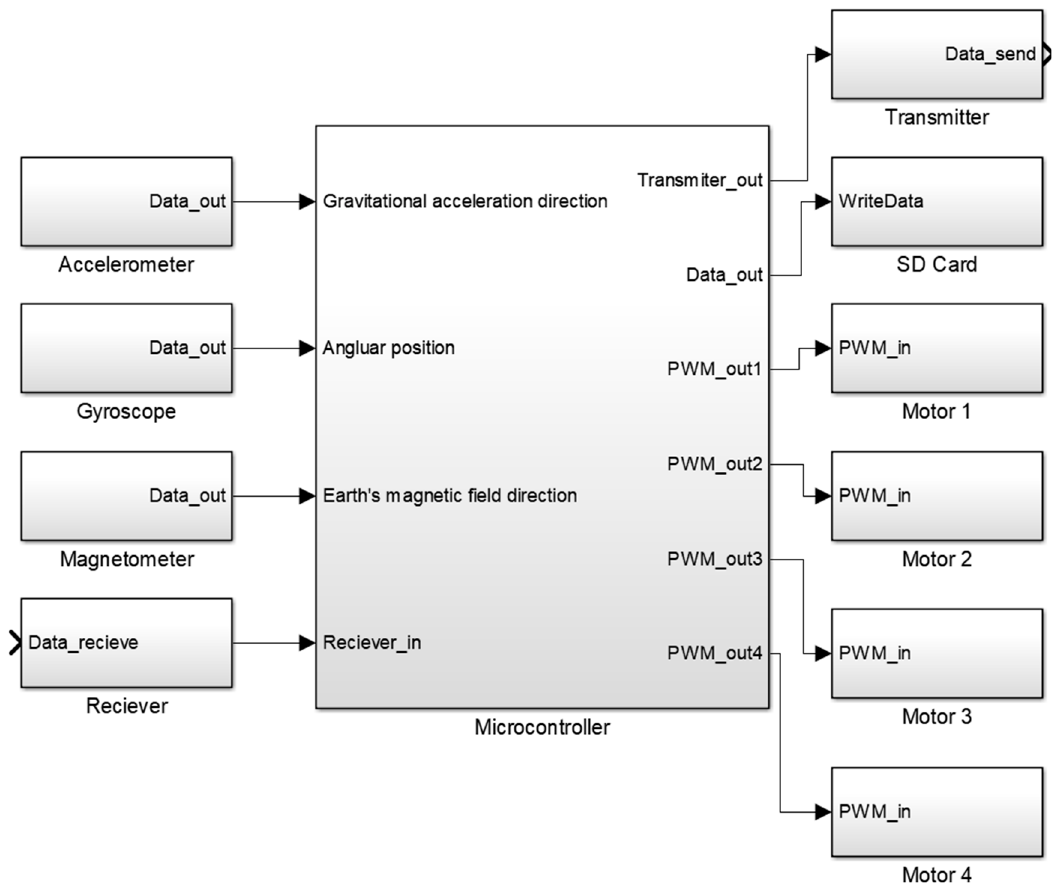
Figure 5. Block scheme of the quadrotor UAV.